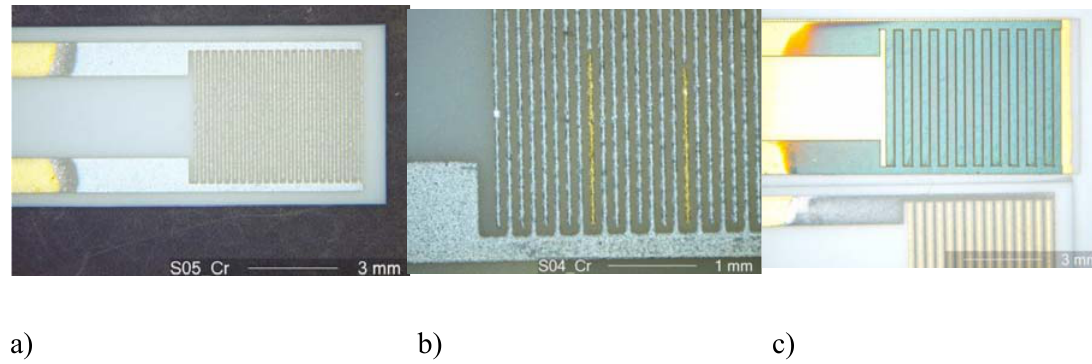
Figure 2. Micrograph of the sensor during the chromium electroplating and oxidation process. (a) electroplated interdigital electrode area (b) details with an erroneous structure (c ) with oxidized Cr O 2 3